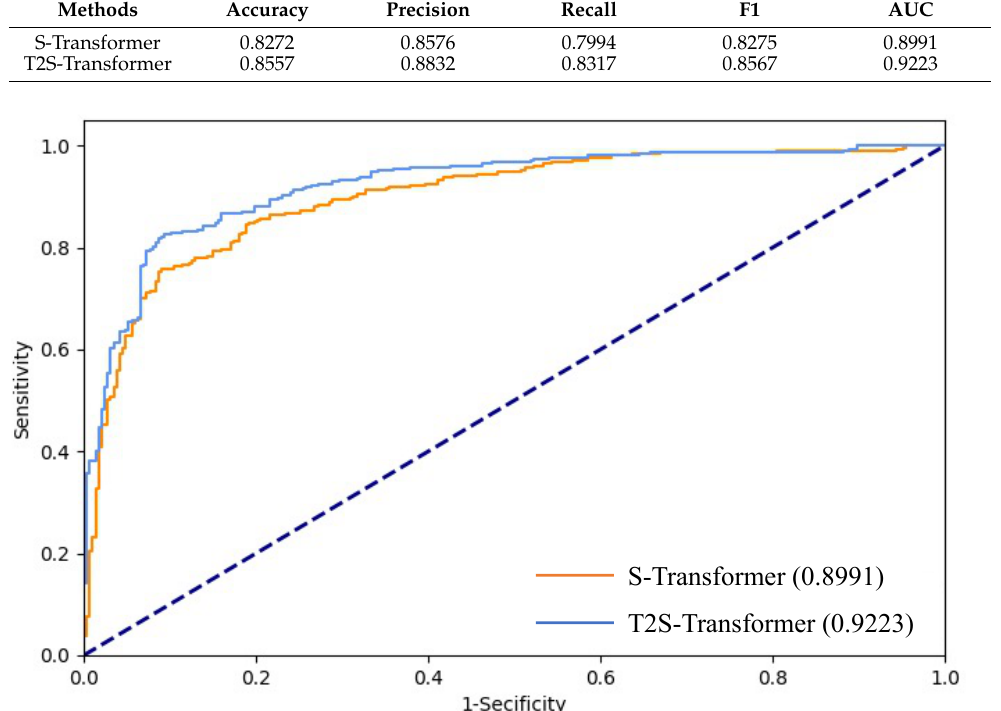
Table 2. Performance comparison between the proposed T2S-Transformer and the naive S-Transformer.